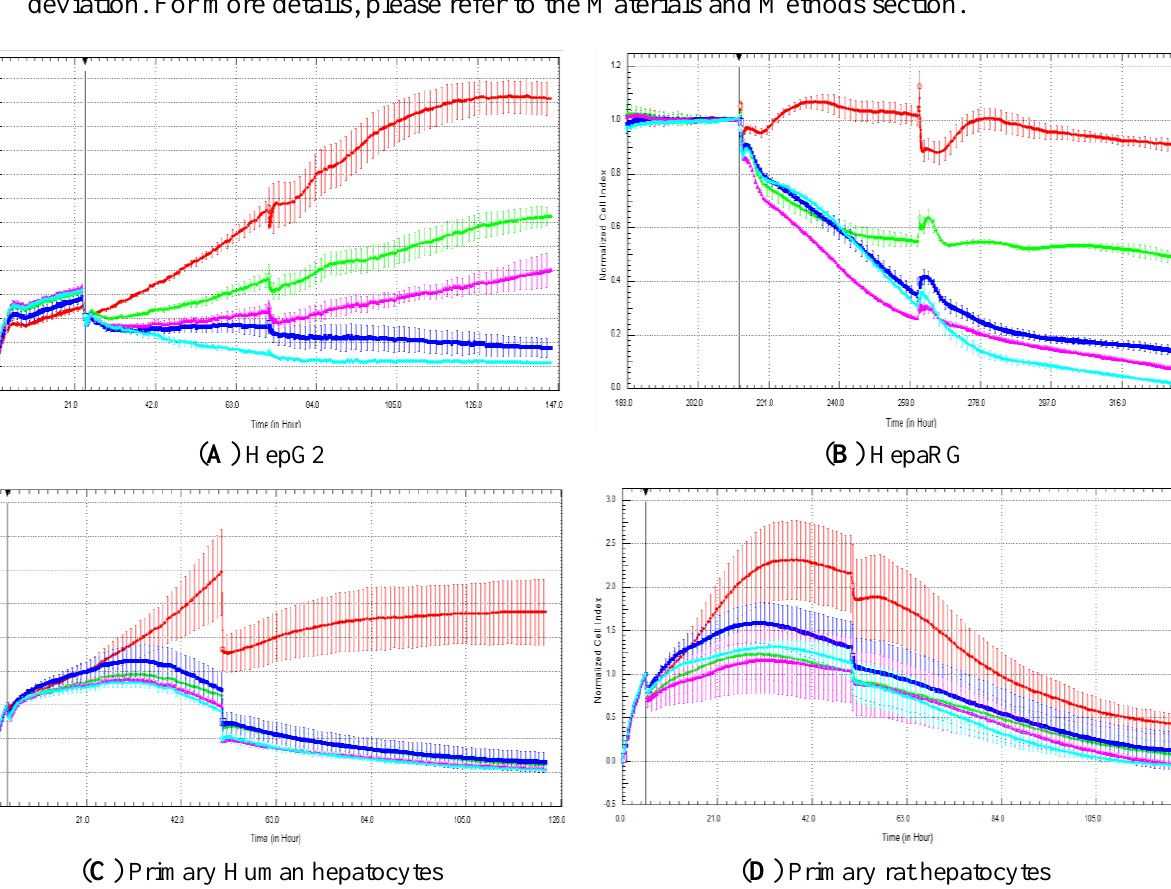
Figure 2. RTCA profiles generated in HepG2, cryopreserved HepaRG, primary rat and human hepatocytes exposed to cerivastatin. Cellular models as indicated in the panels A , B , C and D . Cells were exposed to: 0 (0.5% DMSO, red curve), 33 (green curve), 66 (purple curve), 132 (dark blue curve) and 264 (light blue curve) µM cerivastatin for five days. The concentration tested were multiple of the Cmax value (Cmax cerivastatin = 2.64 µM), i.e ., 12.5, 25, 50 and 100 Cmax. Cerivastatin was added on day 0 (close to the vertical line) and day two. Cell indexes were normalized with the last time point before compound addition. The normalized time point is indicated by the vertical line. Each data point was calculated from triplicate values (except for control cells n = 6). Data represent the average ± standard deviation. For more details, please refer to the Materials and Methods section.